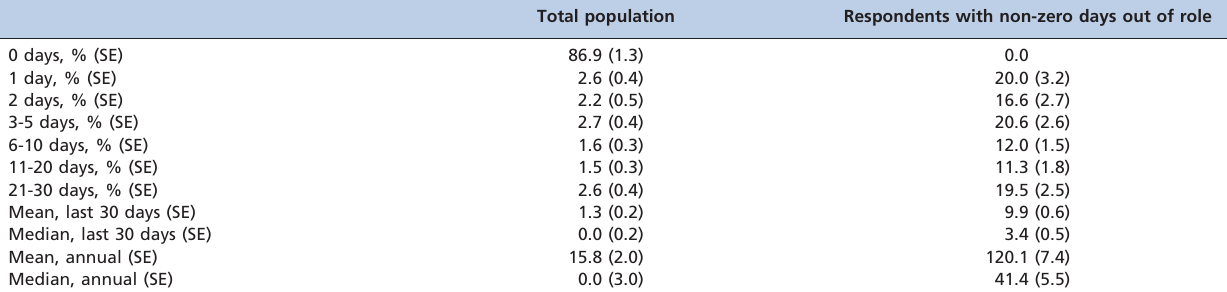
Table 2 - Distribution of the number of days completely out of role in the month prior to the interview among the total population and among respondents with a positive number of days out of role. Data were obtained from the Sa˜o Paulo Megacity Mental Health Survey (n= 2,942).